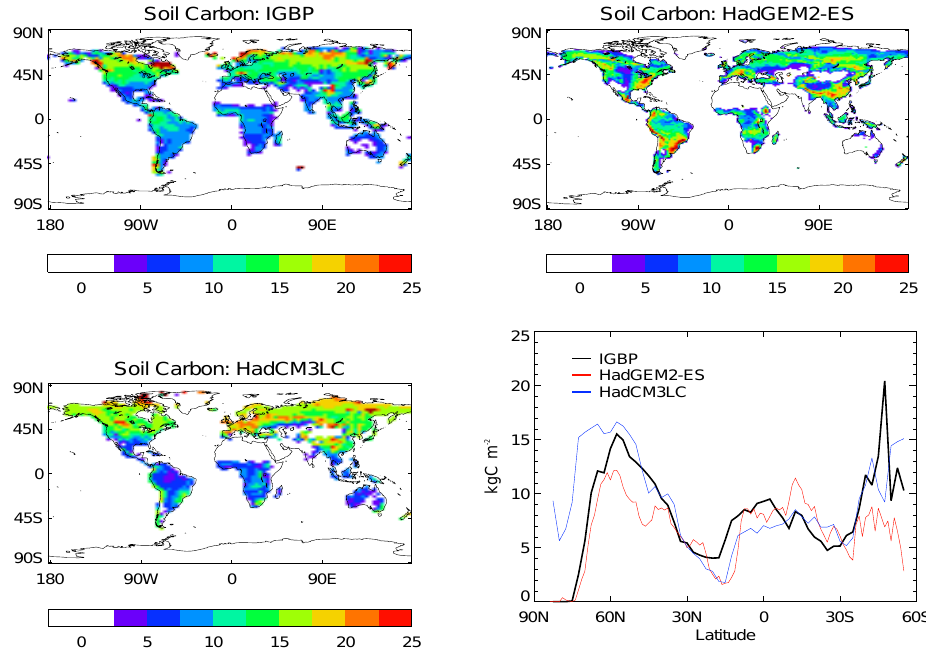
Fig. 16. Climatological (Zinke et al., 1986) and simulated (HadGEM2-ES top right, HadCM3LC bottom left) soil carbon distributions. Bottom right shows a comparison of the zonal means of these